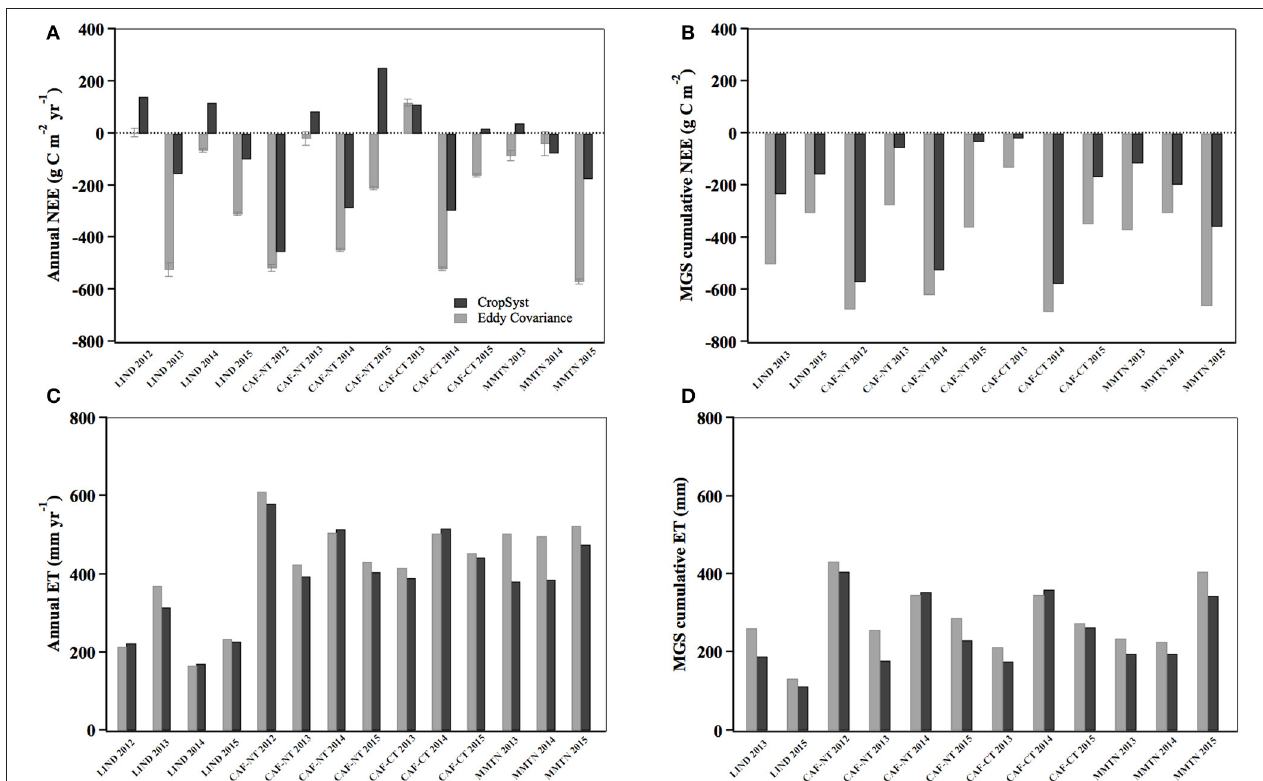
FIGURE 4 | CropSyst and eddy covariance annual (A,C) and main growing season (MGS, B,D ) cumulative net ecosystem exchange of CO 2 (NEE) and evapotranspiration (ET) for each site-year. Error bars are the uncertainties in the eddy covariance annual NEE (A)